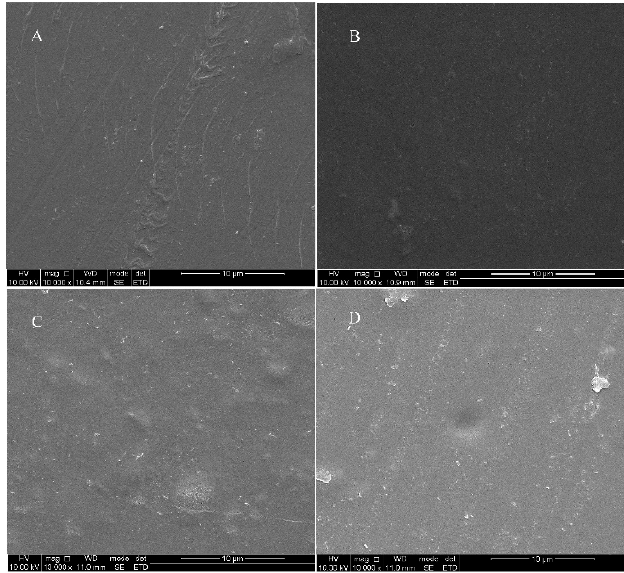
Figure 4. SEM micrographs of regenerated microcrystalline cellulose (MCC)films from different regeneration baths: ( A ) methanol; ( B ) ethanol; ( C ) 5 wt % NaOH (aq.); ( D ) 5 wt % H 2 SO 4 (aq.).